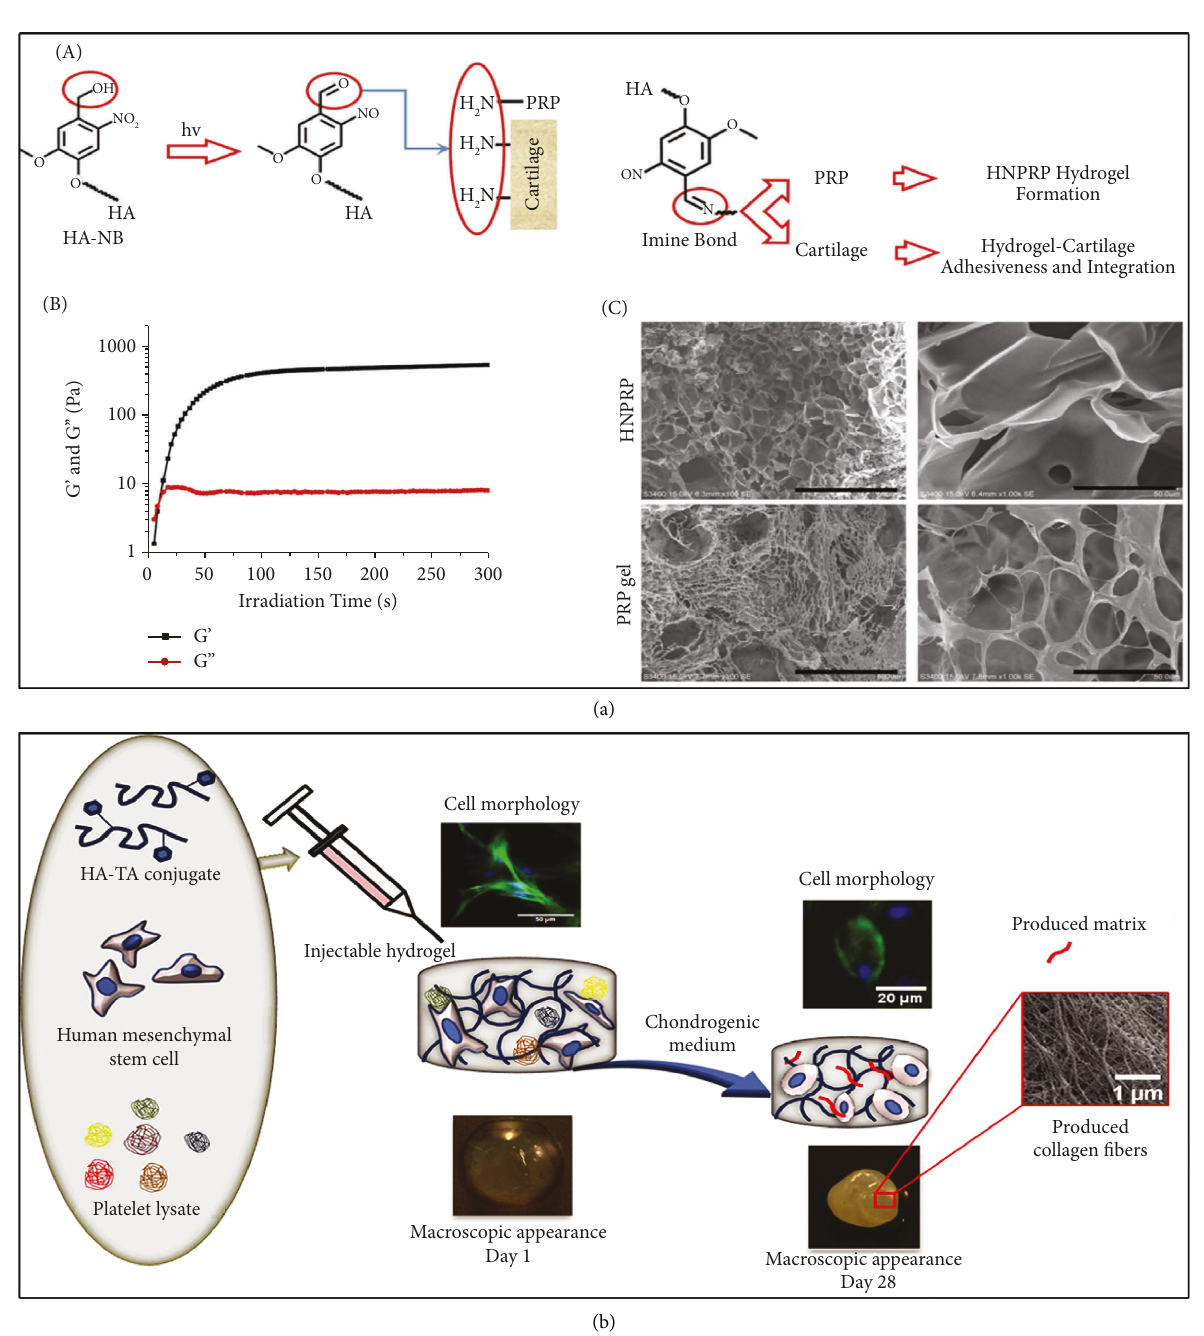
Figure 3: Various PRP-loaded hydrogel systems for cartilage regeneration. (a) Characterization of HNPRP hydrogel: (A) schematic il- lustration of the gelling mechanism of HNPRP hydrogel and its covalent adhesiveness and integration to native cartilage; (B) rheological property of HNPRP hydrogel precursor solution (40mg/mL HA-NB saline solution blended with the same volume of extracted rabbit blood PRP) under light irradiation at 37 ° C; and (C) SEM images of freeze-dried HNPRP hydrogel glue and thrombin-activated PRP gel; (b) preparation of platelet lysate-incorporated HA-TA-PL hydrogels and its promotive effect on the viability, proliferation, and chondrogenesis of hMSCs. Adapted with permission from Liu et al. [123] and Jooybar et al.